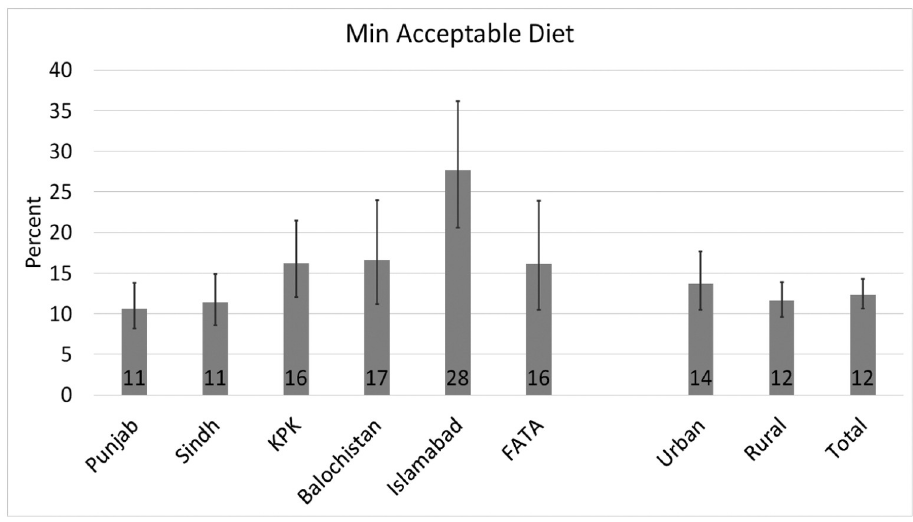
Fig 3. Prevalence of minimum acceptable diet aged 6–23 months across regions and urban/rural areas in Pakistan (2017–18): 95% confidence intervals are represented by error bars. Source: Author using DHS (2017–18) data.